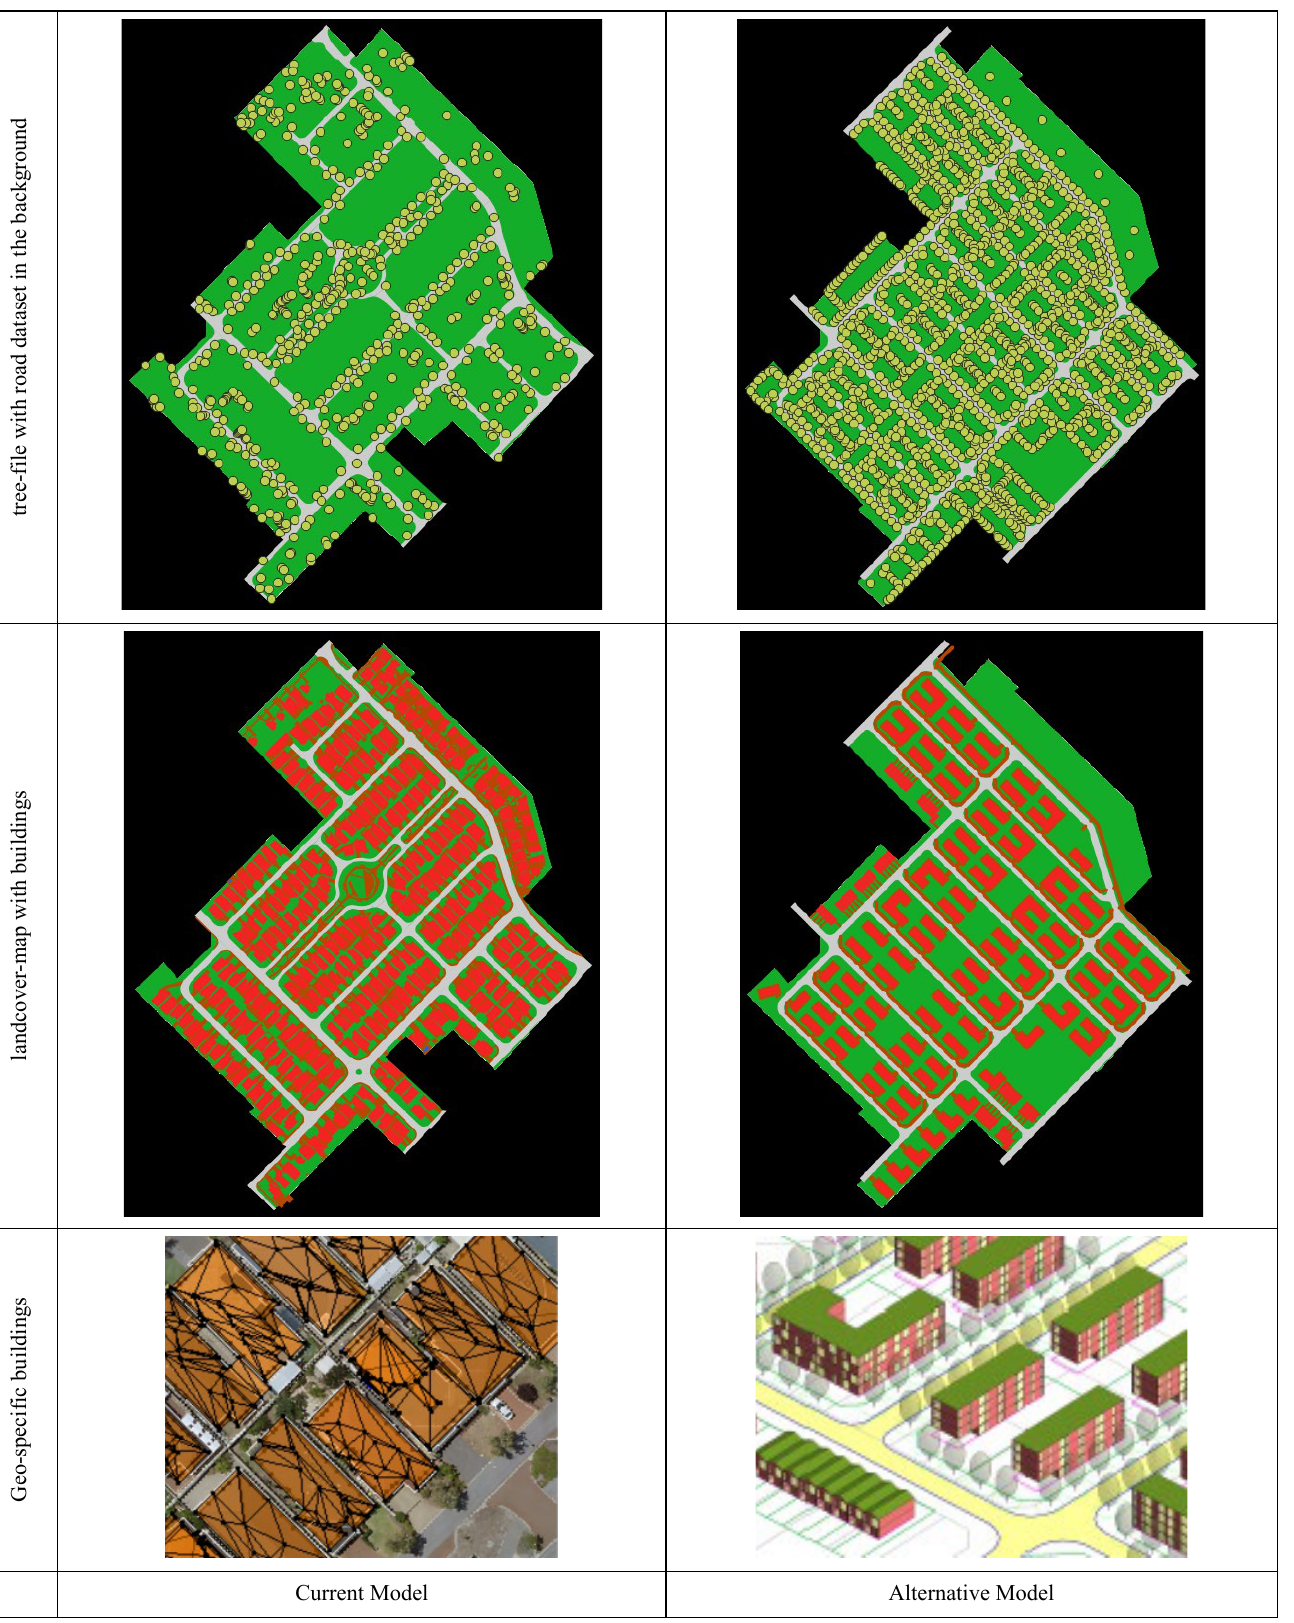
Figure 3: The tree locations (top row), the landcover map (middle row) and a fragment showing of geo-typical buildings (bottom row) for the Current Model (left) and the Alternative Model (right). The colours for the landcover map are green (grass), red (building), brown (paving/soil) and grey (road/asphalt). In the bottom left image, the buildings overlay the ortho-image, which is not available for future